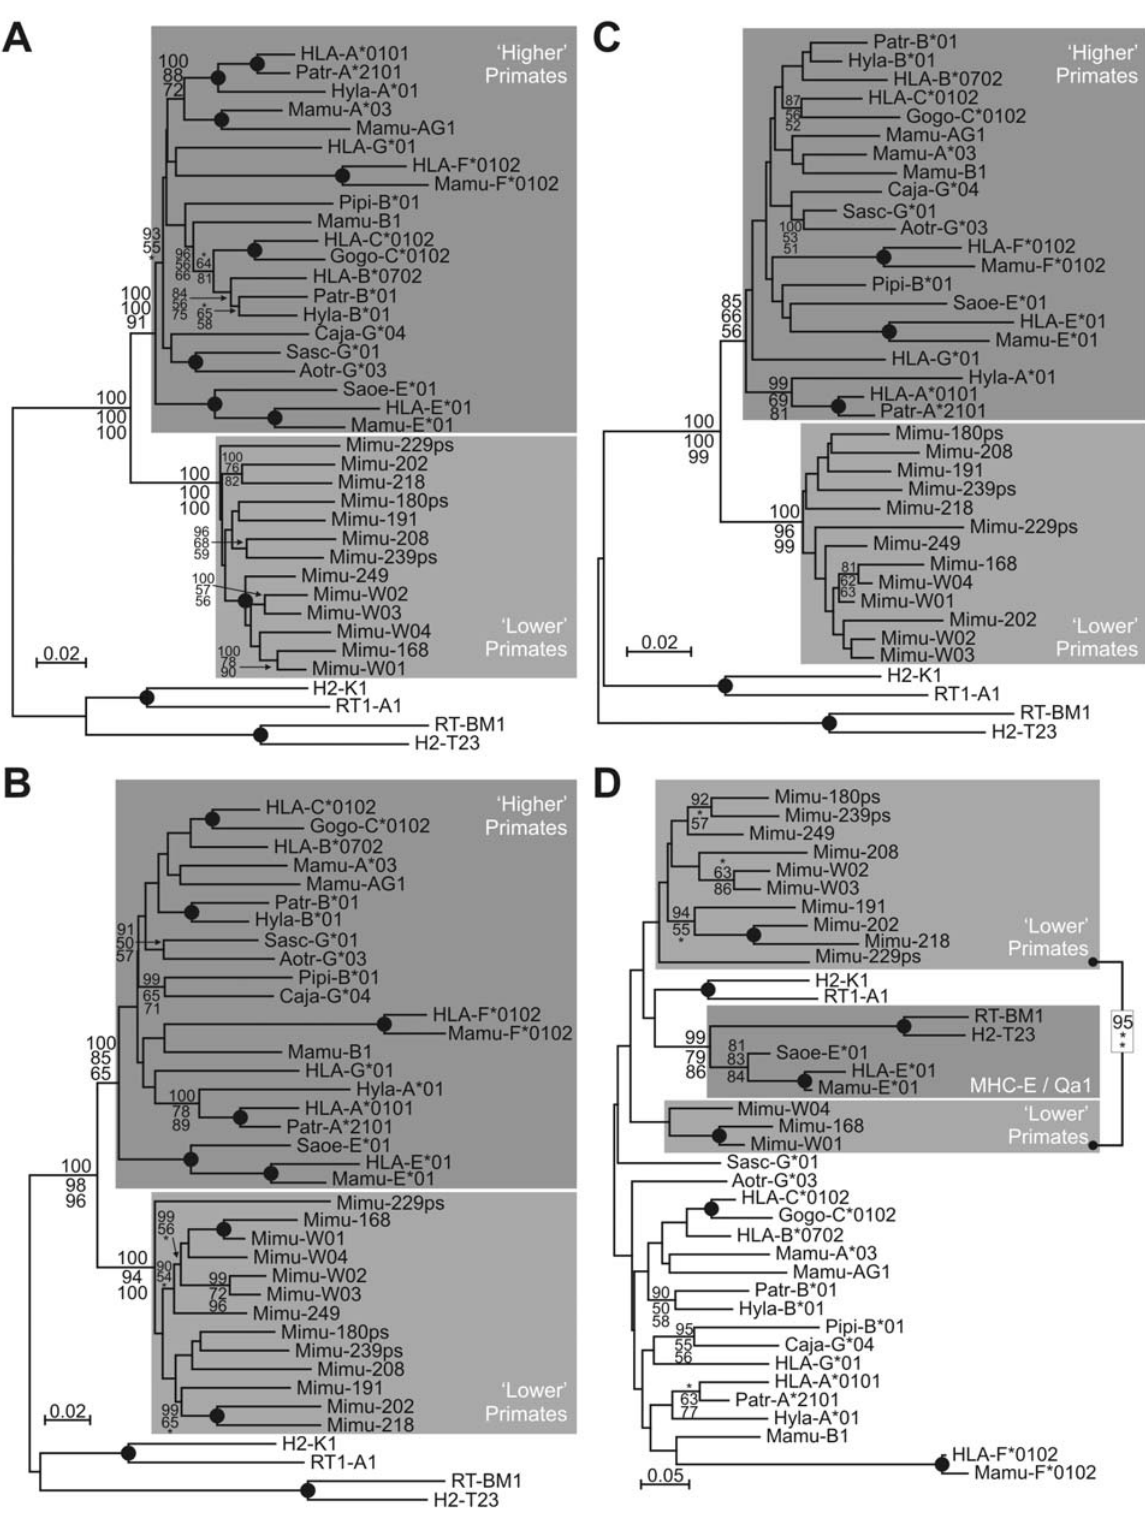
Figure 4. ‘‘Lower’’ primates lack a strict ortholog or functional equivalent of ‘‘higher’’ primate MHC-E. Phylogenetic analyses of MHC class I genes with complete coding sequences (A), peptide binding domain (B), peptide binding domain excluding peptide binding residues (C) and peptide binding residues only (D). A phylogenetic analysis of MHC class I genes with complete coding sequences excluding the peptide binding residues was also conducted and the results are presented in Figure S5. Analysis and display are as described for Figure 3. Numbers as gene names for MHC class I are the same as in Figure 1C. Non-primate sequences included are mouse (H2) and rat (RT1). Peptide binding residues were defined according to Bjorkman et al. [44]. Patr, Pan troglodytes; Gogo, Gorilla gorilla; Hyla, Hylobates lar; Saoe, Saguinus oedipus; Sasc, Saimiri sciureus; Mamu, Macaca mulatta; Mimu, Microcebus murinus; Aotr, Aotus trivirgatus; Caja, Callithrix jacchus; Pipi, Pithecia pithecia.